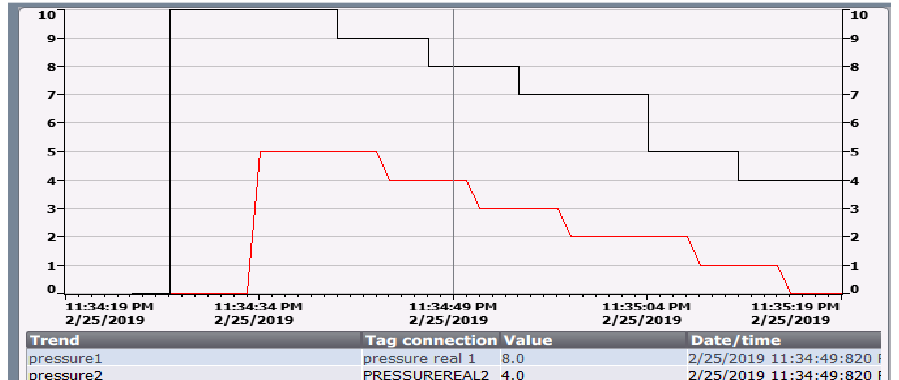
Fig. 12. trend in touch panel . Two alarms were sat up. The discrete alarm would be appeared if there were not enough number of the work piece in the feeding tube.